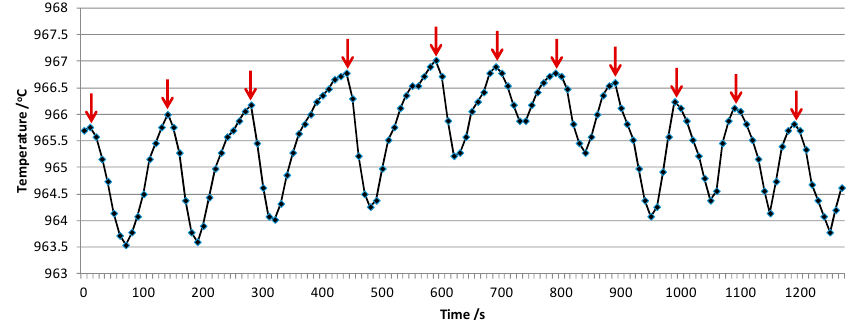
Figure 5. Temperatures measured on site via thermocouple (arrow refers to feeding moment of number 6 feeder).